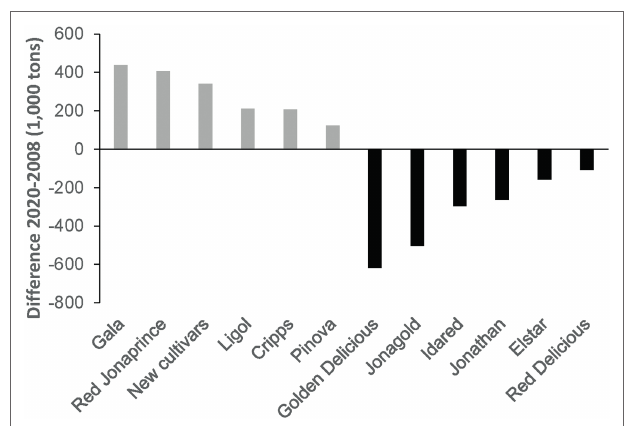
FIGURE 1 | Development of the harvest volumes of selected apple cultivars in the EU in comparison with the years 2008 and 2020